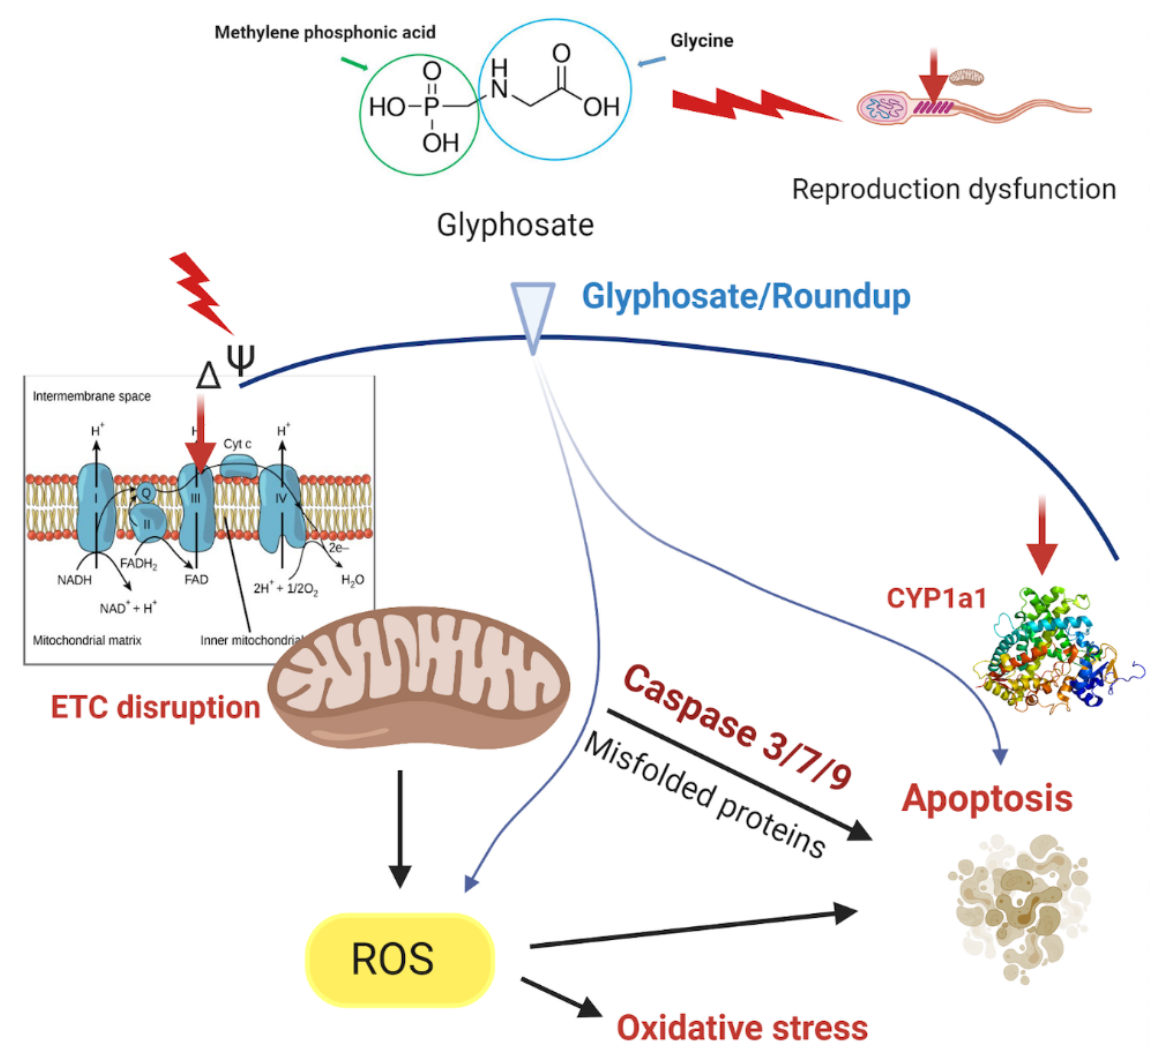
Figure 2: Effects of glyphosate and Roundup related to